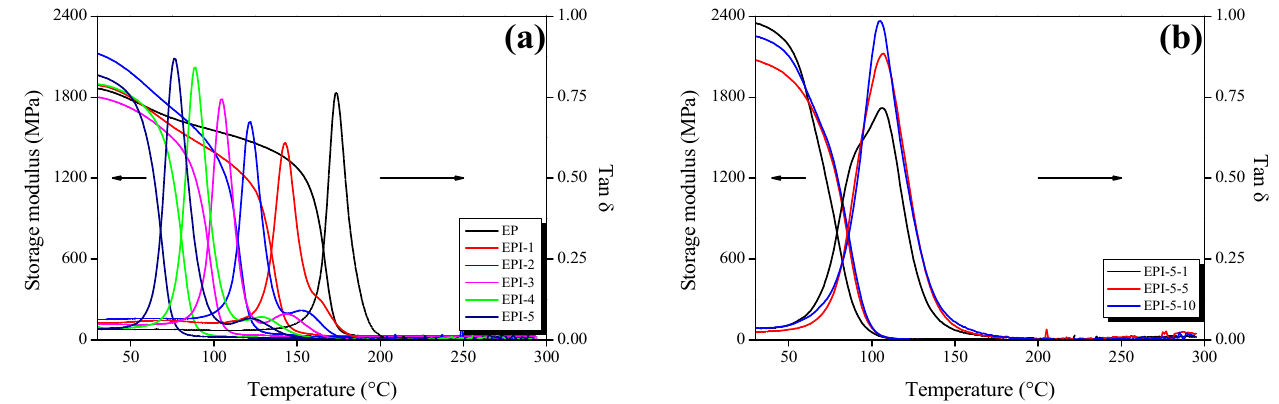
Figure 3. Storage moduli and tan δ values of cured epoxy/polyimide blends by dynamic mechanical analysis (DMA) in N 2 gas atmosphere; ( a ) cured EPI and ( b ) postcured EPI. Table 2. Crosslinking density of cured epoxy/polyimide blends by dynamic mechanical analysis (DMA) in N 2 gas atmosphere.